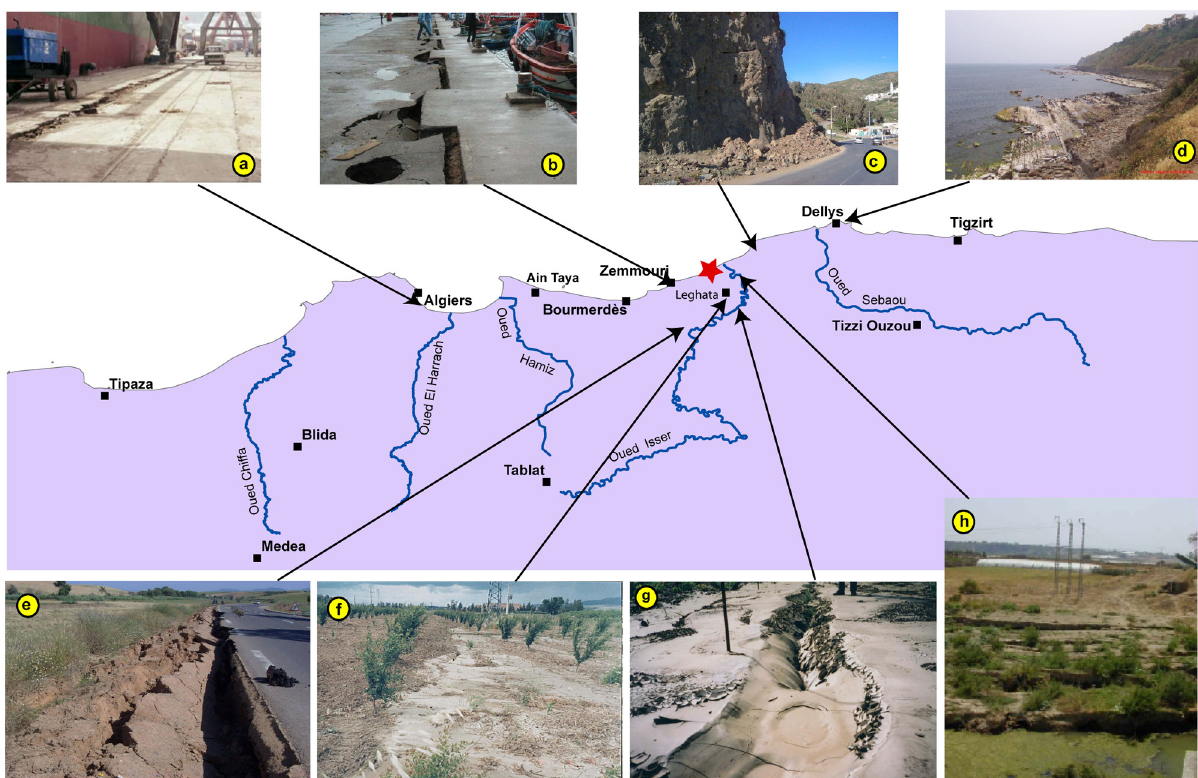
Figure 4. Ground effects observed after the Boumerdès earthquake. (a), (b) Photos of damage observed in Algiers Harbor and Zemmouri Harbor (close to the epicenter), respectively, with ground settlement >30 cm; (c) rock falls alongside NR 24 between Zemmouri and Dellys villages; (d) coastal uplift of about 50 cm near Dellys village (the white level is the uplifted seafloor); (e) cracks along national road south of Zemmouri village; (f) liquefaction-induced sand flow into an irrigation ditch in Zemmouri; (g) liquefaction-induced sand boils near Isser River; (h) tension cracks caused by lateral spreading of the river bank of Isser River; Red star: main shock.